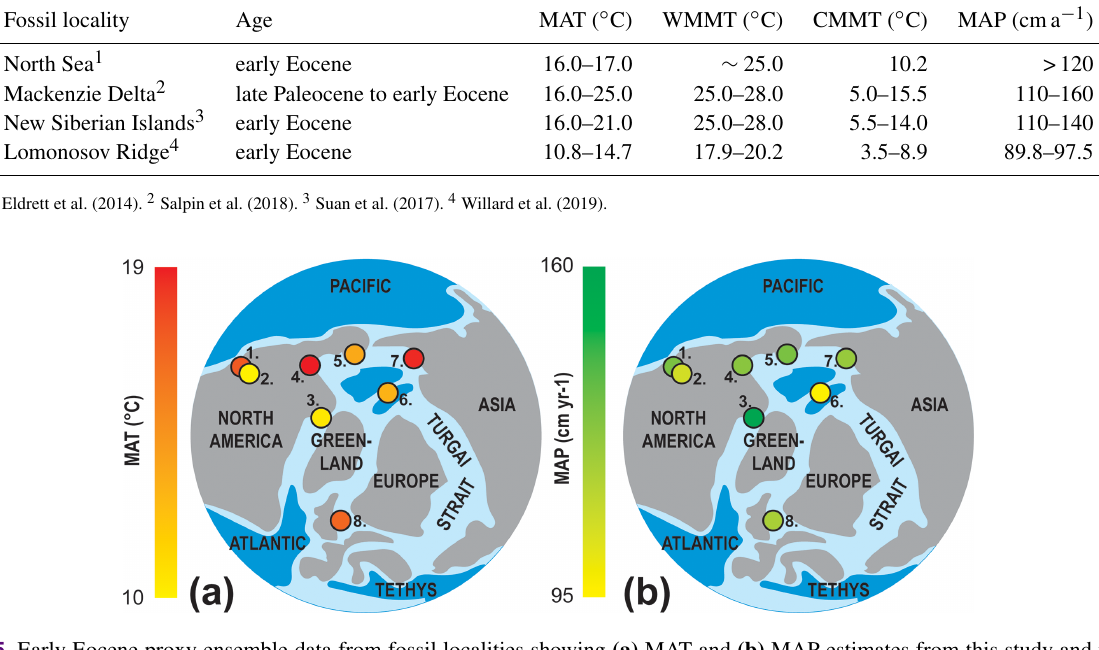
Figure 5. Early Eocene proxy ensemble data from fossil localities showing (a) MAT and (b) MAP estimates from this study and the prior studies compiled in Table 3. 1. Racehorse Creek, Washington, 2. Okanagan Highlands, British Columbia and Washington, 3. Canadian Arctic, Ellesmere and Axel Heiberg islands, Nunavut, 4. Mackenzie Delta, Northwest Territories, 5. Evan Jones Mine, Alaska, 6. Lomonosov Ridge, 7. New Siberian Islands, Russia 8. North